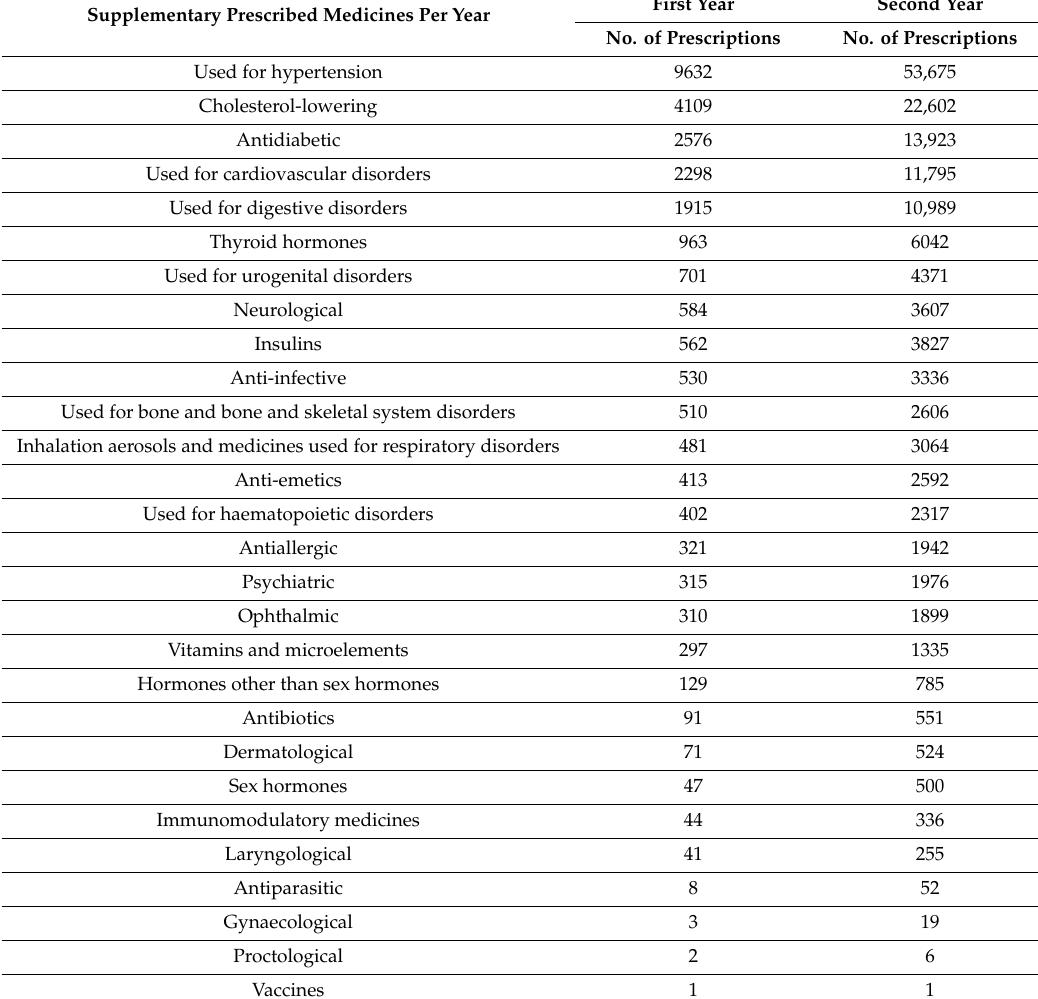
Table 6. Number of nurse supplementary prescriptions issued for specific groups of medicinal products during the implementation